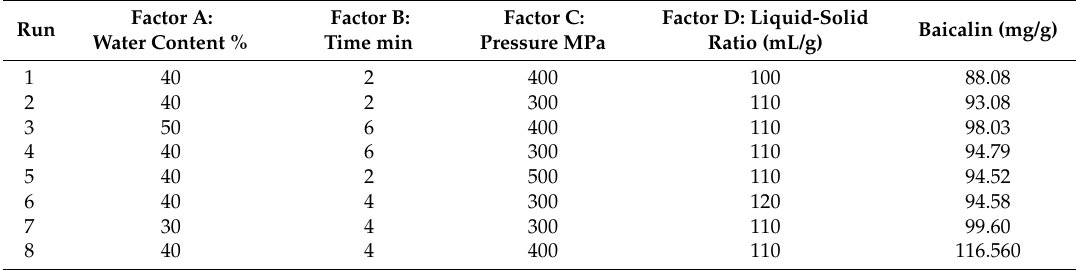
Table 4. Box–Behnken design with independent variables and measured